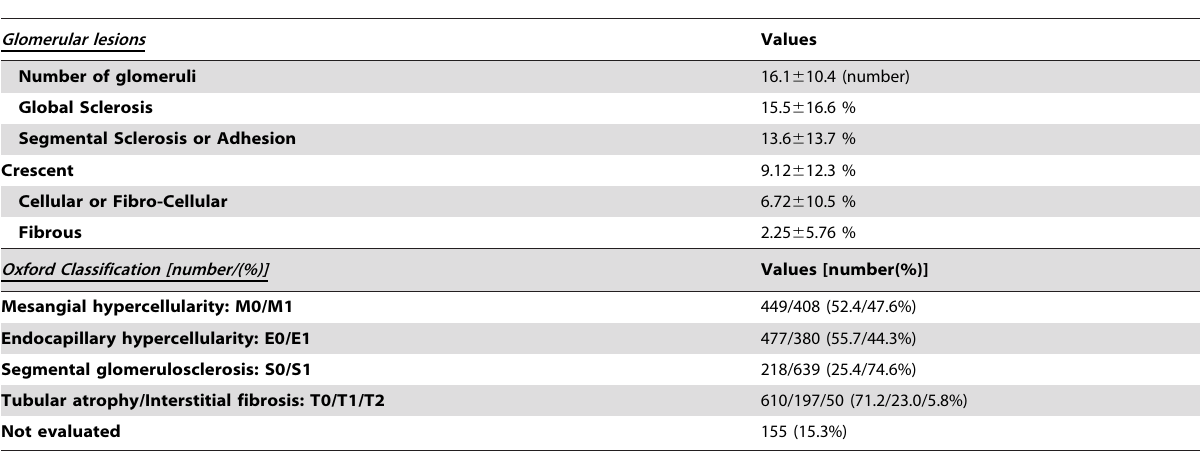
Table 2. Histological findings (glomerular lesions and Oxford